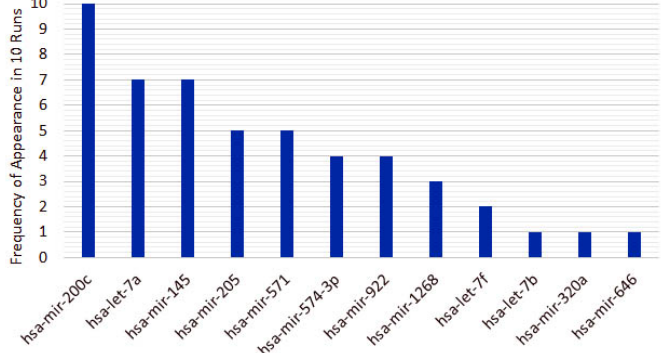
Figure 6. Ten recurrent features in the 5-feature signature for the heterogeneous ensemble feature selection algorithm.